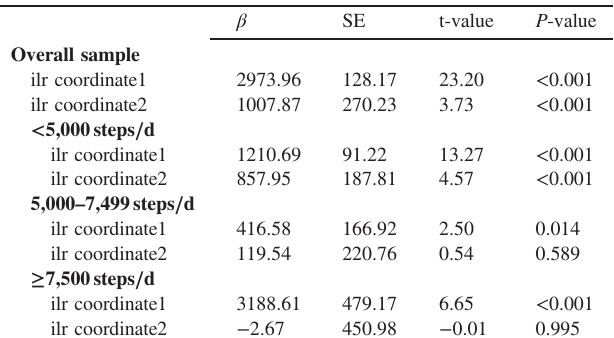
Table 3. Compositional regression analysis of the relationships of sedentary and physically active behaviors with daily